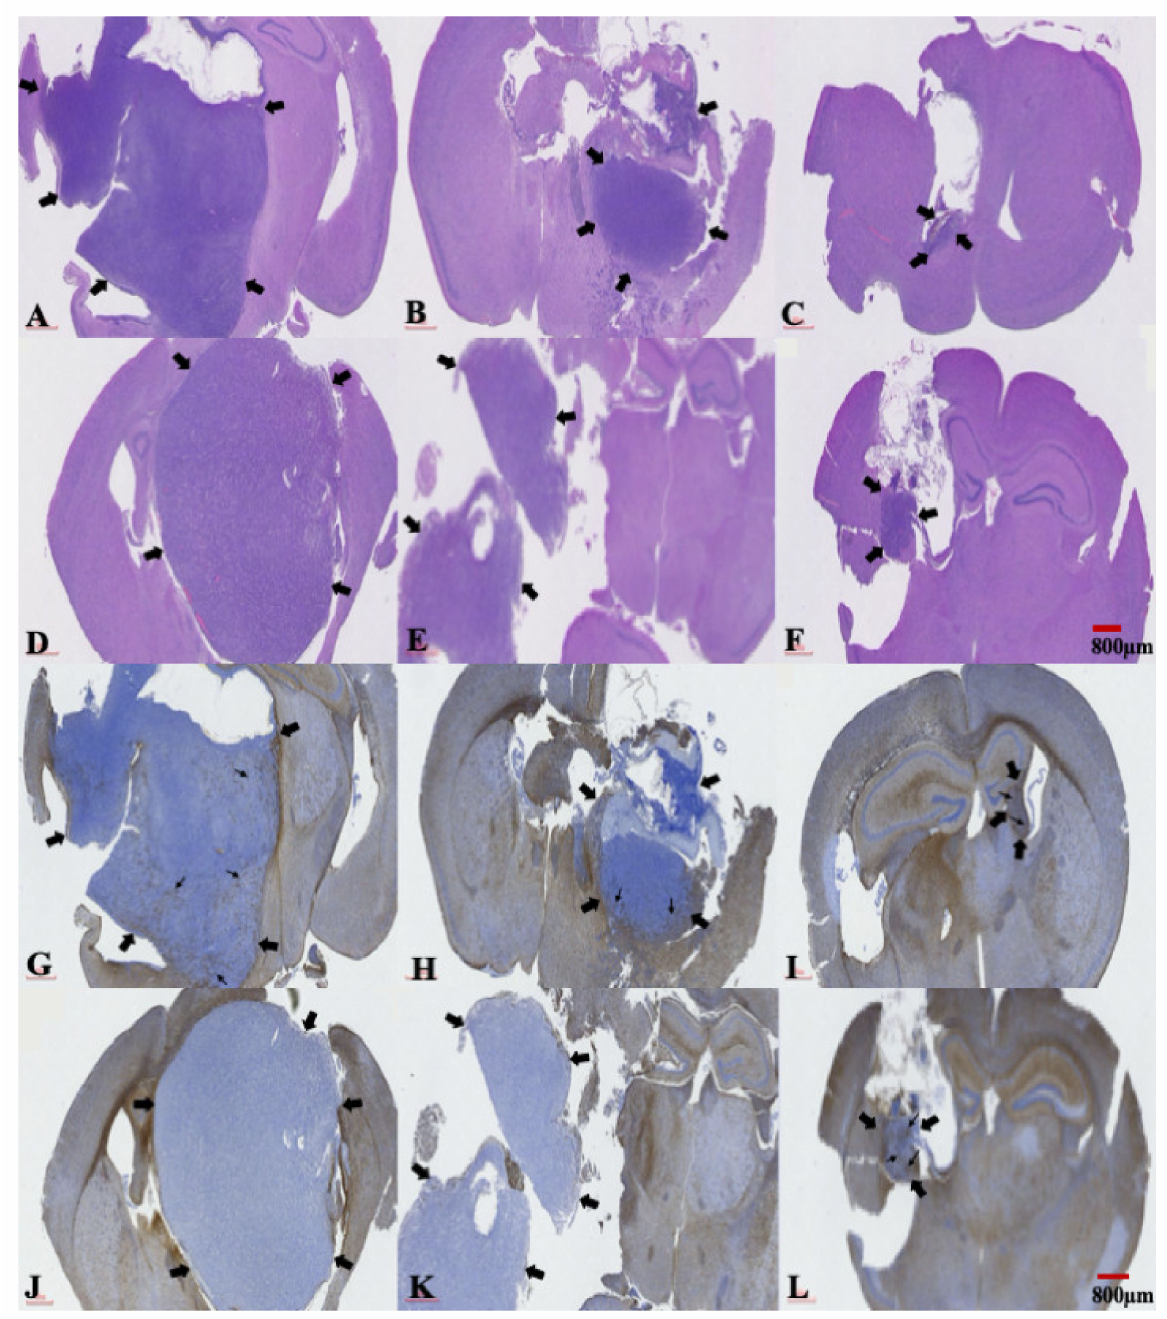
Figure 6. Staining of U87 and U87-TR xenografted tumor regions following treatment with TMZ vehicle, TMZ-combined Gliadel, or TMZ-combined SMPs. ( A – F ) represent H&E staining and ( G – L ) represent GFAP immunocytochemical staining. Mice bearing U87 xenografts treated with TMZ vehicle: ( A , G ); TMZ-combined Gliadel: ( B , H ); TMZ-combined SMPs: ( C , I ). Mice bearing U87-TR xenografts treated with TMZ vehicle: ( D , J ); TMZ-combined Gliadel: ( E , K ); TMZ-combined SMPs: ( F , L ). The thick arrows in Figure 6A–L indicate the margin of tumor and the thin arrows in Figure 6G–L indicate the intratumoral GFAP positive